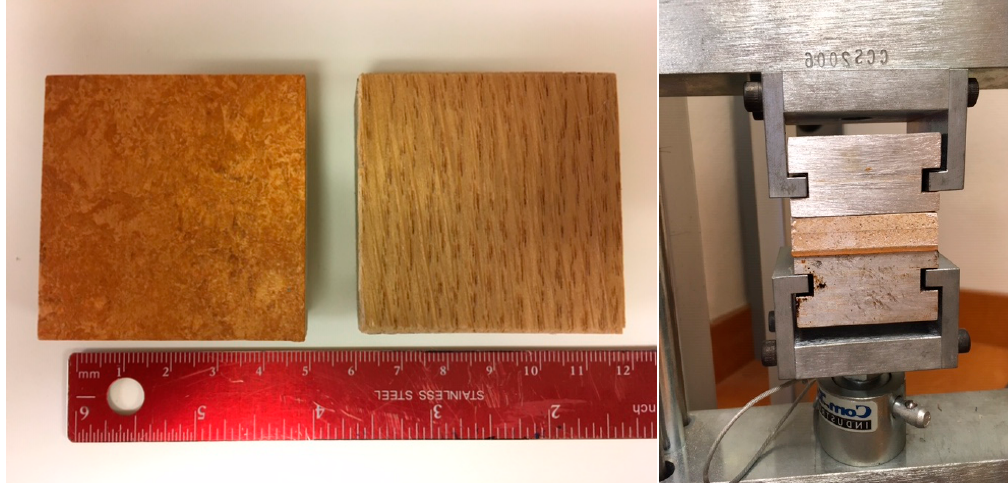
Figure 1. Internal bond strength (IB) samples and IB test set-up showing the cross section of the sample. (Left is linoleum overlaid and the right one is oak veneered sample).